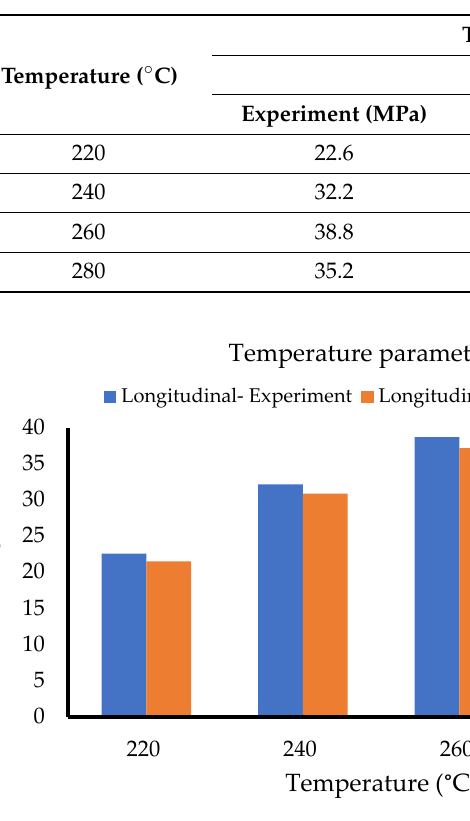
Table 8. Modelling results for the temperature set (Method 1).